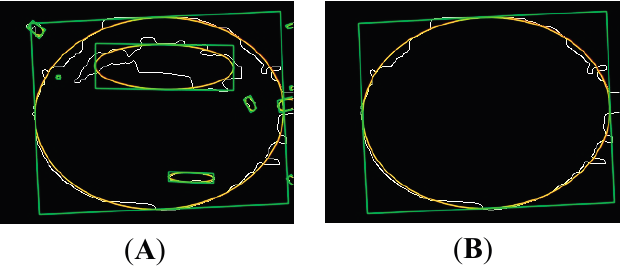
Figure 15. Ellipse/circle detection ( A ) Family ellipses detected ( B ) Steering wheel.